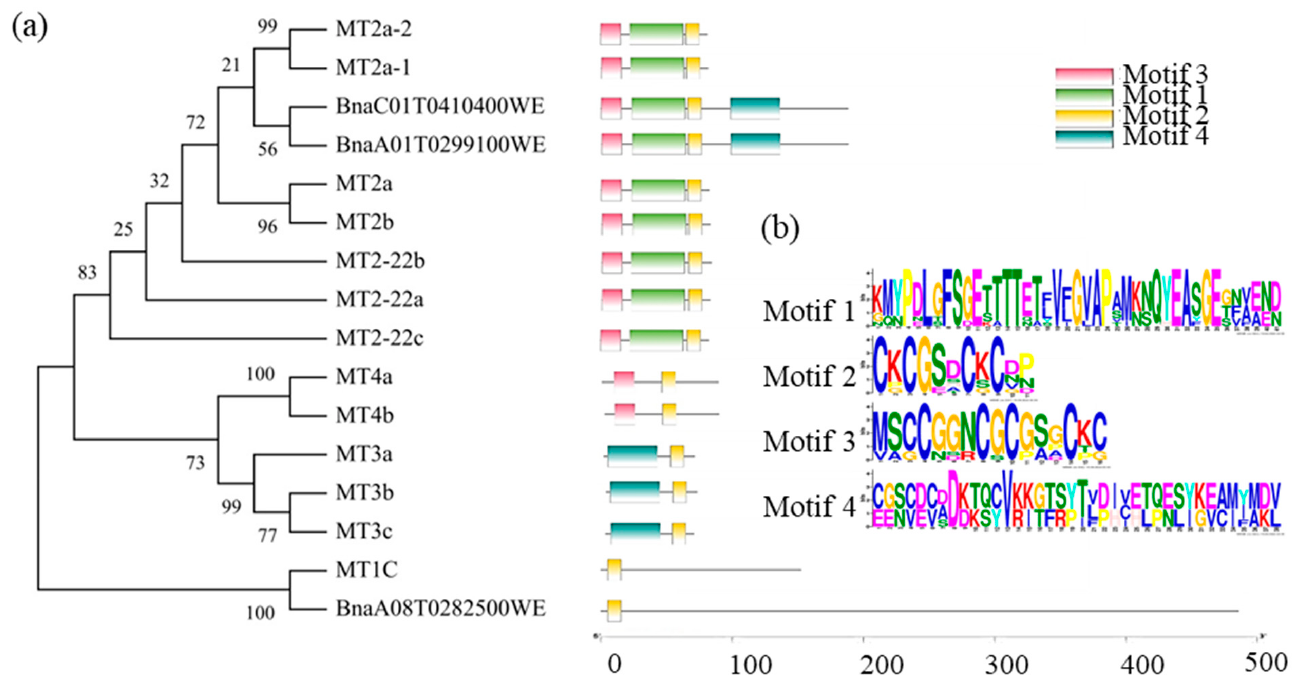
Figure 2. Identification and motif analysis of metallothionein proteins in Brassica napus cv. Westar. ( a ) Phylogenetic tree and motifs analysis of metallothionein family from Brassica napus cv. Westar. ( b ) Details of the motifs of metallothioneins from Brassica napus cv. Westar.